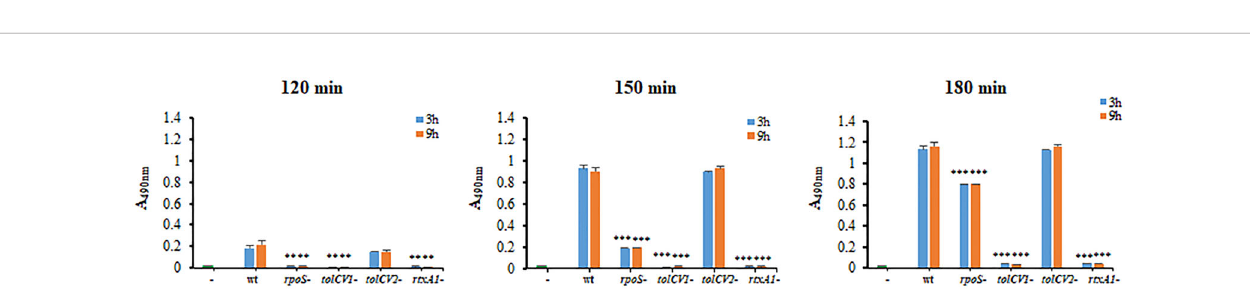
FIGURE 2 | Effect of tolCV1 or tolCV2 mutation on RtxA1 expression and secretion after contact with host cells. HeLa cells cultured overnight in 6-well plates (5×10 5 cells/well) were infected with either V. vulni fi cus wild-type (wt), rpoS mutant ( rpoS -), tolCV1 mutant ( tolCV1 -), tolCV2 mutant ( tolCV2 -), or rtxA1 mutant ( rtxA1 -) strains at an MOI of 20 for 120, 150, or 180 min. RtxA1 protein in the supernatants and cell lysates were detected by Western blot analysis with an RtxA1 antibody speci fi c to amino acids 1492-1970 (RtxA1-D2 domain). Relative protein levels were quanti fi ed using ImageJ software. Results are representative of at least three independent experiments.